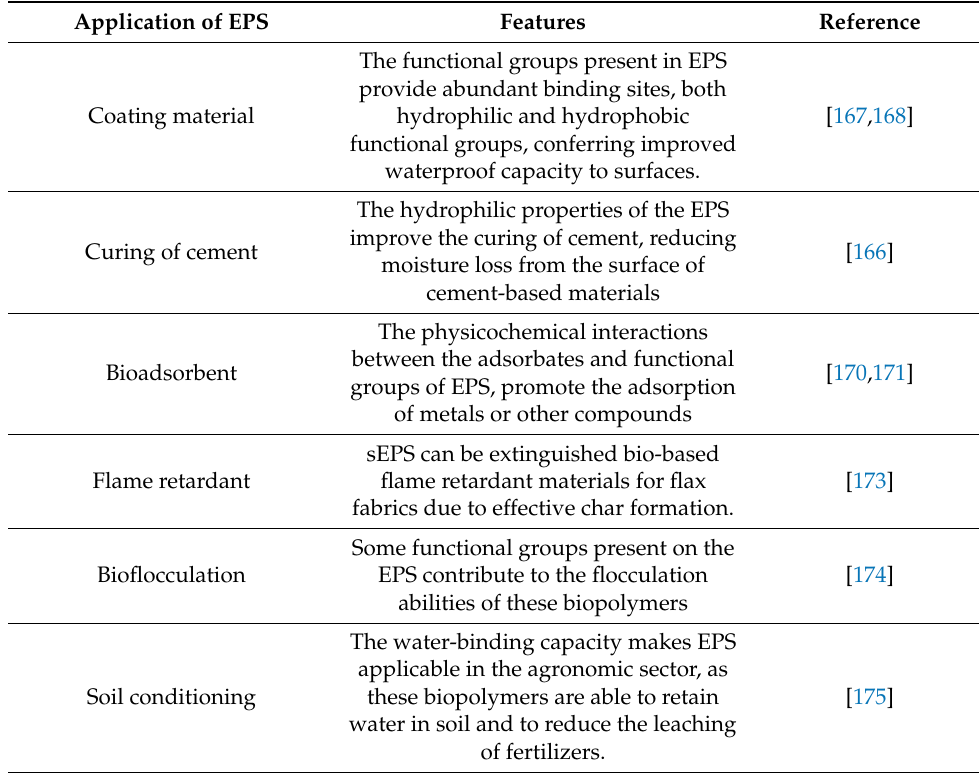
Table 12. Applications of the recovered EPS in the different industrial